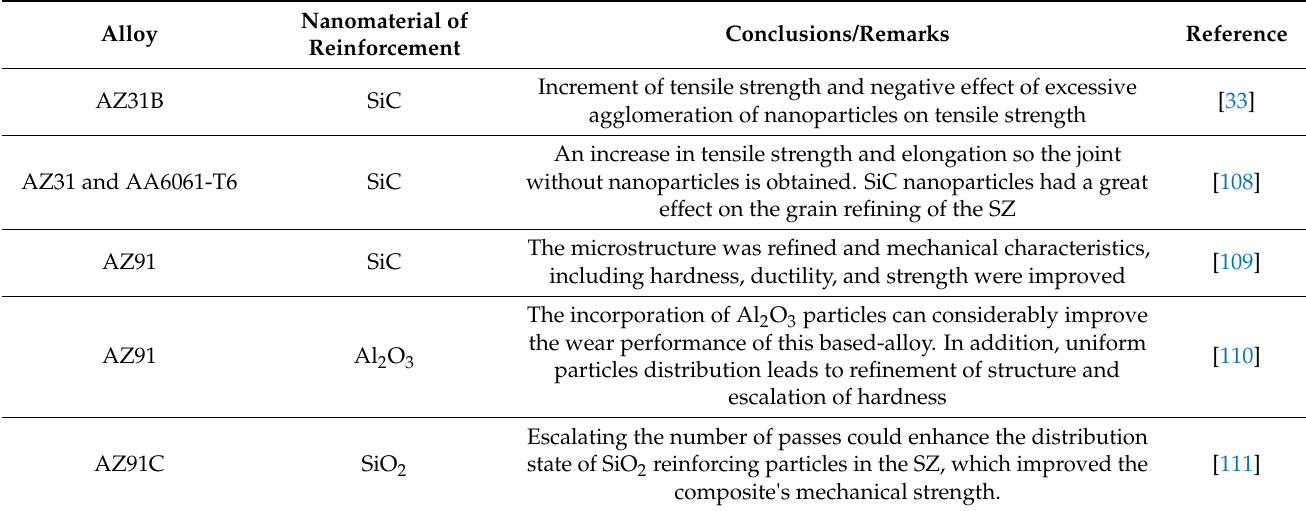
Table 3. Research summary of nanoparticles reinforced materials subjected to the FSW and FSP.